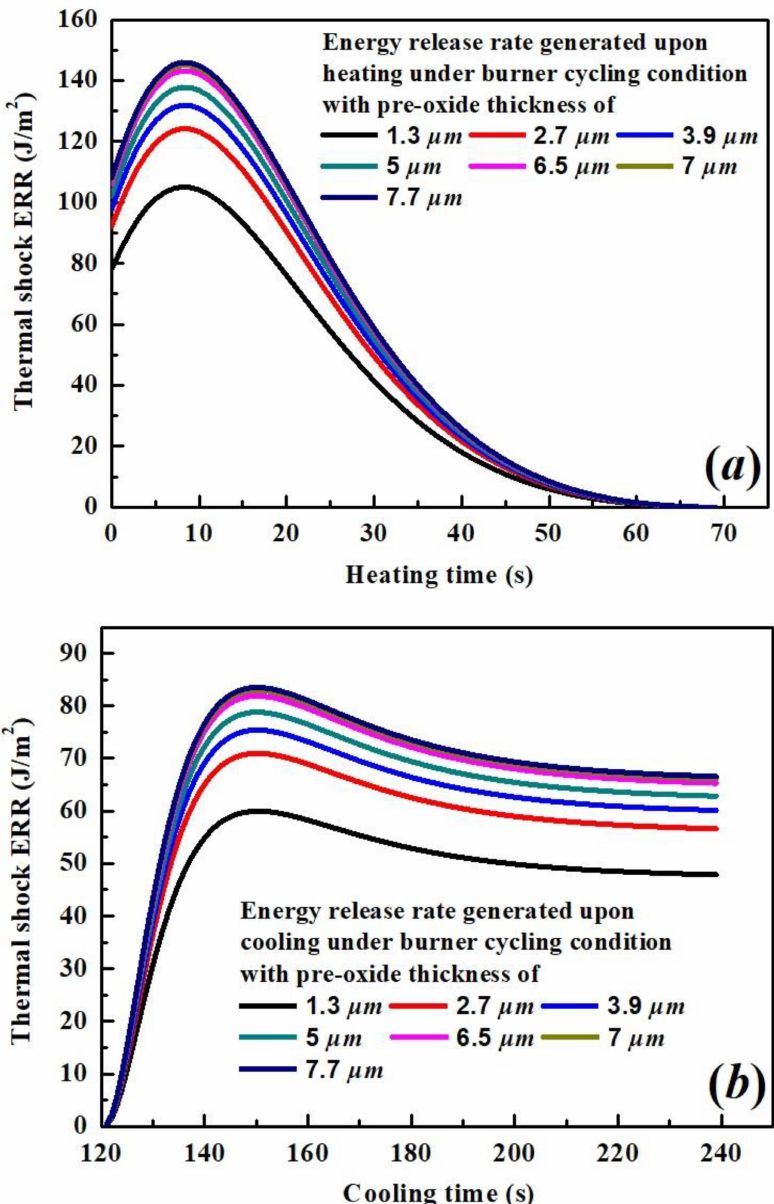
Figure 18. The calculated thermal shock ERR developed upon ( a ) heating; ( b ) cooling vs. time under different pre-oxide TGO